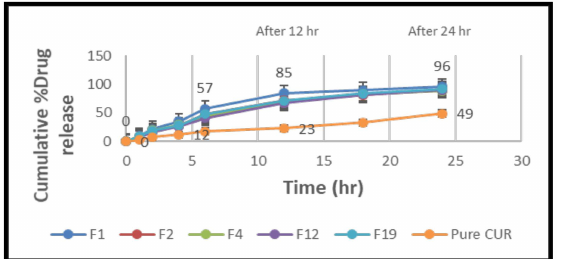
Figure 10. Comparison of cumulative % drug release NLC formulas (F1, F2, F4, F12, and F19) and pure curcumin suspension versus time (h), mean ± SD (n =